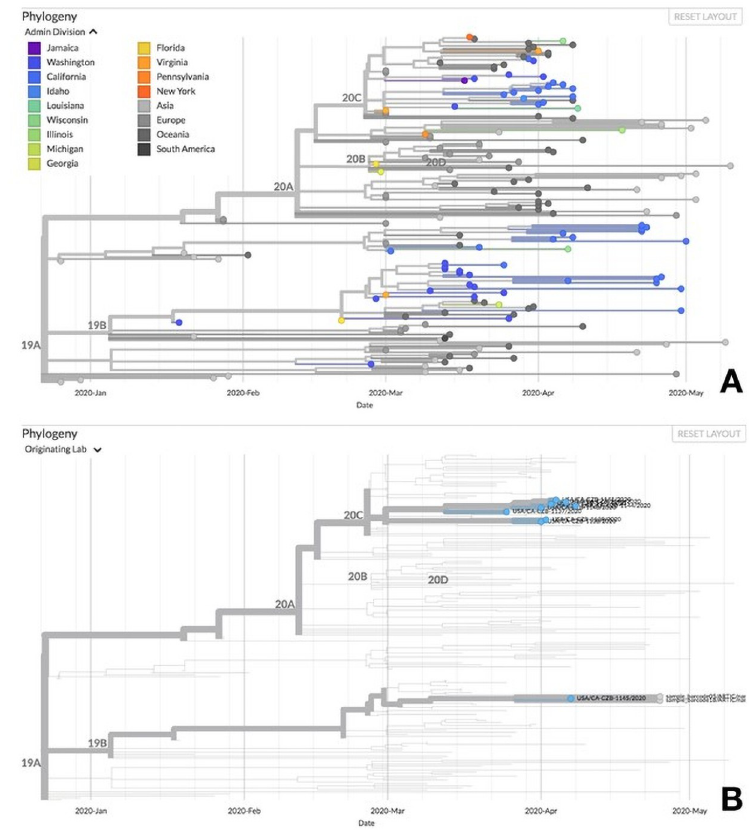
Fig 5. Phylogenetic comparison of the SARS-CoV-2 sequences obtained from environmental swabs at UCDMC. A . Near-complete genomes obtained from environmental samples clustered in clade 19B. The phylogenetic tree was generated using the NextStrain protocol, and compares sequences to others amplified in Sacramento County in California. B . Environmental genome sequences may have originated from a single patient, or from multiple patients infected with similar viruses. All publicly available patient samples originating from UC Davis are shown as blue points at the tips of the phylogeny. Note that most sequences from UC Davis in this time period are members of the 20C clade, as opposed to the environmental sequences that are members of clade 19B together with sample USA/CA-CZB- 1145/2020.